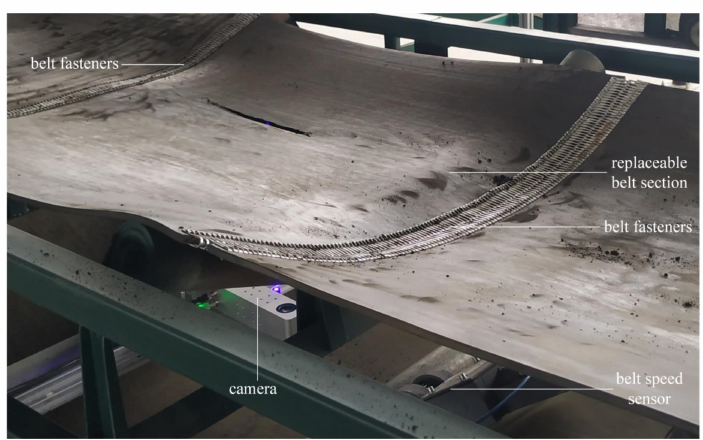
Figure 8. The simulation experiment platform in laboratory; only the replaceable belt section needs to be replaced rather than the whole belt in each